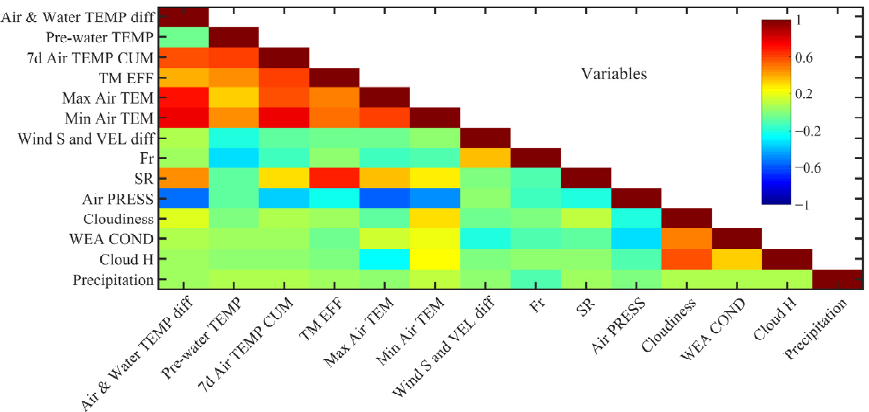
Figure 2. Diagram for correlation analysis of influencing factors of water temperature.